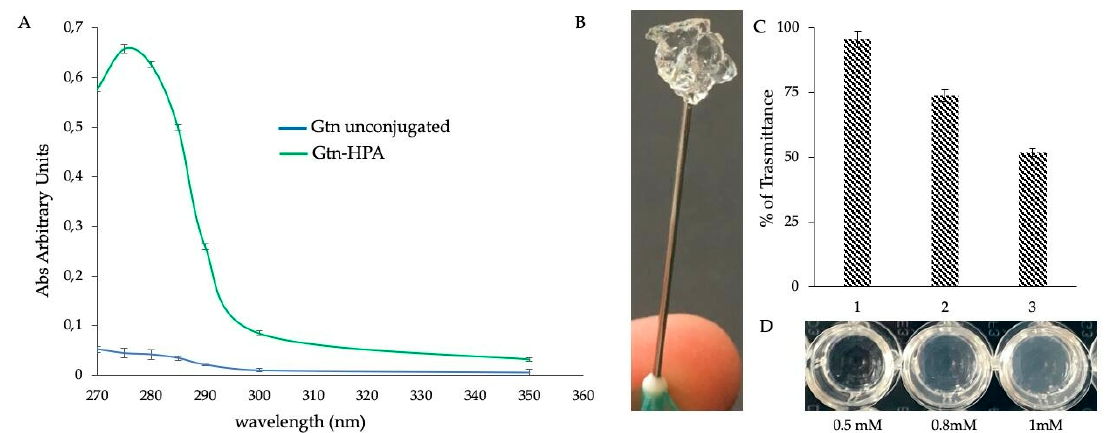
Figure 2. Functionalization of fish gelatin. ( A ) Analysis of the absorption spectra of fish gelatin (Gtn) after conjugation with hydroxy-phenyl-propionic acid (HPA; green curve), compared to the unconjugated Gtn used as a control (blue curve). Bars represent mean ± SD ( n = 3). ( B ) Hydrogel of functionalized Gtn-HPA cross-linked by HPR and H 2 O 2 enzymatic reaction. ( C ) Determination of hydrogel stiffness degree by transmittance analysis. The higher density of the gel, due to a higher cross-linking number, is inversely proportional to the percentage (%) of transmittance. The solution of Gtn-HPA uncross-linked was used as control. Transmittance was read at 700 nm. In correspondence with the histogram, the relative images of the hydrogel. Bars represent mean ± SD ( n = 3). ( D ) show the increase in H 2 O 2 concentrations, from 0.5 to 1 mM, augmented by the number of cross-linking and the opacity of the gel.